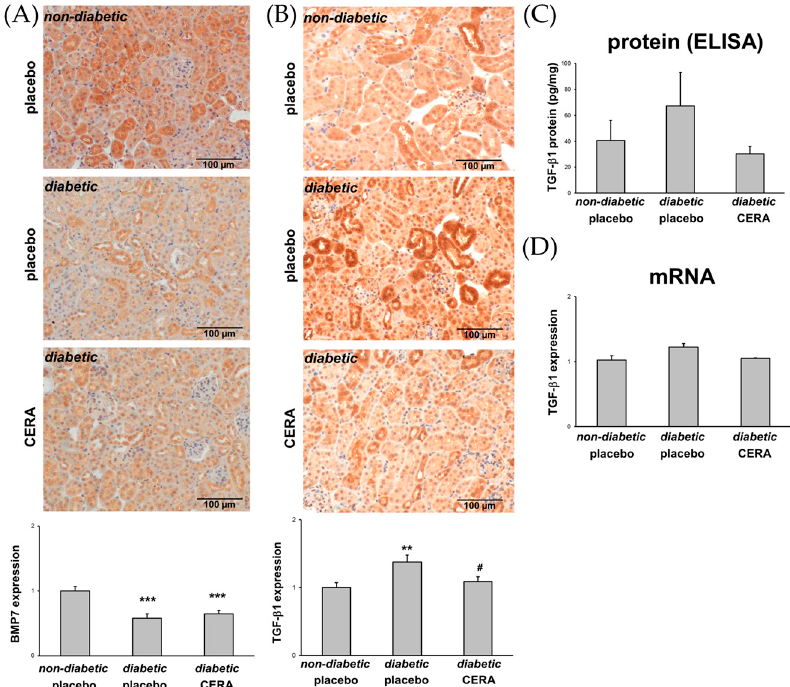
Figure 3. Analyses of CERA effects on the renal expression of the TGF- β superfamily members BMP7 and TGF- β 1. ( A ) BMP7. Representative images of BMP7 immunohistochemistry (magnification: 200 × ) and semi-quantitative analysis of the staining (graph); ( B ) TGF- β 1. Representative images of TGF- β 1 immunohistochemistry (magnification: 200 × ) and semi-quantitative analysis of the staining (graph); ( C ) TGF- β 1 protein. Activated TGF- β 1 protein levels in lysates of the renal tissue. The TGF- β 1 concentration in the kidney is expressed as pg/mg of total protein; ( D ) TGF- β 1 mRNA. Real-time PCR analysis of the renal TGF-1 mRNA expression. Values were normalized to the expression of housekeeping genes. The inhibition of the BMP7 expression in diabetic kidneys, compared to healthy controls, is not influenced by CERA treatment. Whereas diabetic kidneys express increased amounts of pro-fibrotic TGF- β 1, the diabetic animals that are treated with CERA show less TGF- β 1 mRNA as well as protein in their renal tissue. ** p ≤ 0.01, *** p ≤ 0.001 = diabetic vs. non-diabetic control; # p ≤ 0.05 = db / db CERA vs. db / db placebo. The non-diabetic controls were assigned as an arbitrary value of 1 (except in ( C )).